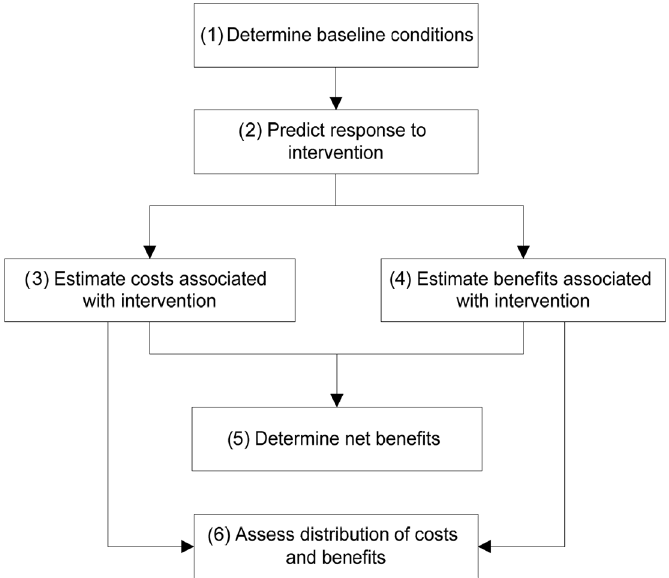
Figure 2. Simplified overview of Cost–Benefit Analysis [14].